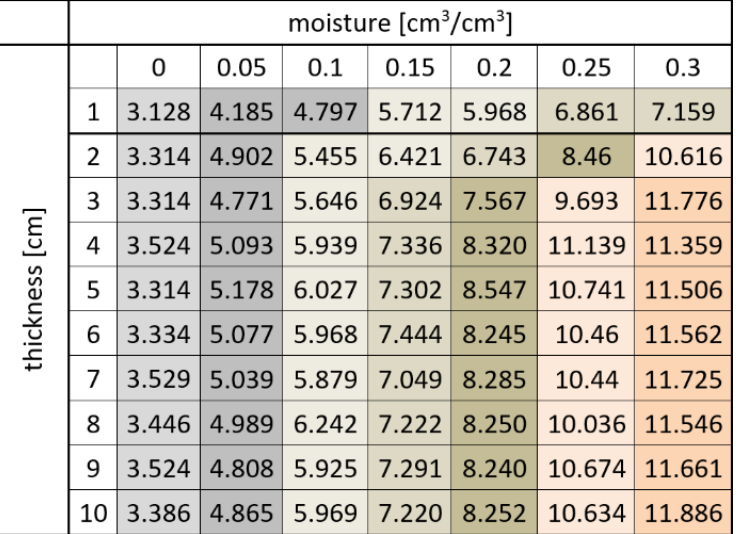
Figure 11. Post hoc analysis of apparent permittivity readouts using sensor B for various values of sample moistures and sample thicknesses. Each color means different homogenous group. Using the ANOVA and Tukey post hoc tests, it was possible to evaluate the maximal range of sensitivity of both sensors. After reaching the exact value depending on material moisture and sample thickness, the increase in apparent permittivity was not measured. From the results presented in Figure 10 representing sensor A, it was noticed that in the case of the dry and low moisture containing samples (0 and 0.05 cm 3 /cm 3 ), all permittivity readouts belong to the same homogenous groups (another one for air dry, another one for